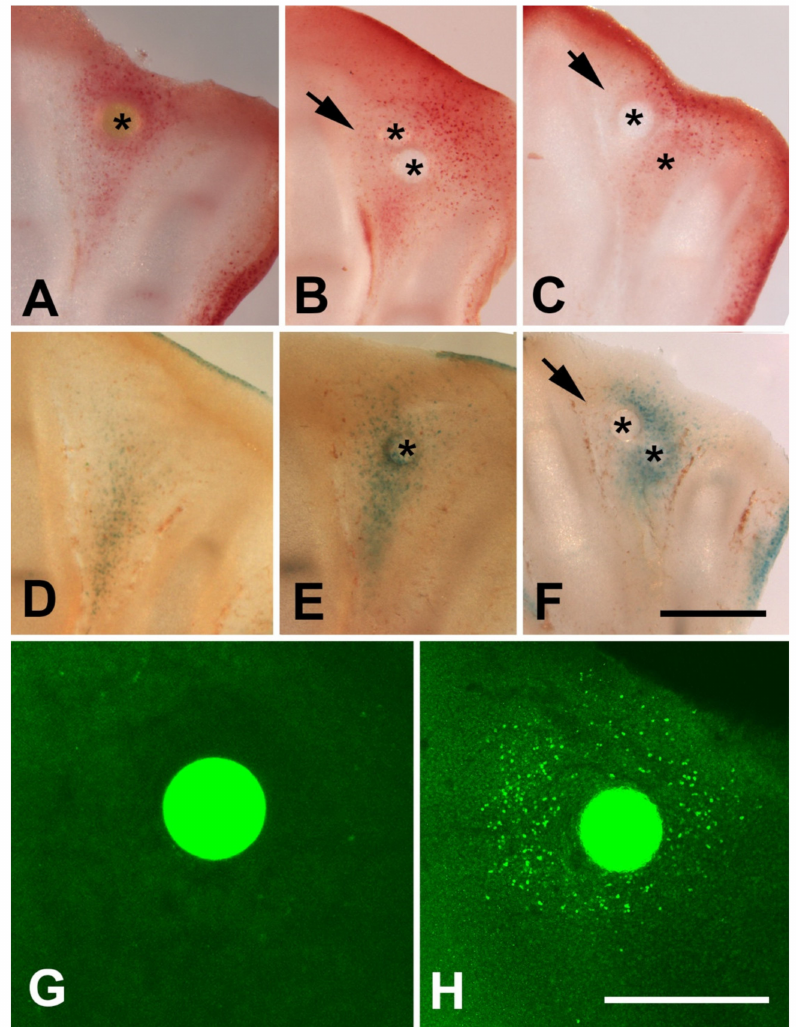
Figure 5. ( A – C ) Vibratome sections of autopods 24 h after interdigital implantation of a TSA bead alone ( A ), double implantation of Noggin and TSA bead ( B ), and double implantation of FGF bead and TSA bead ( C ). ( D – F ) Vibratome sections showing the pattern of β -galactosidase activity in control untreated ( D ) 24 h after implantation of a TSA bead, and 24 h after double implantation of a FGF bead and a TSA bead. Asterisks indicate the position of the beads. Note the inhibition of neutral red labeling and β -galactosidase activity in the zone close to Noggin and FGF bead (arrows) in comparison with single TSA treatments in ( A , E ). ( G , H ) Absence of γ H2AX-positive cells 8 h after implantation of a control PBS bead ( G ) and intense labeling after implantation of a TSA bead ( H ). Magnification bar in ( A – F ) = 400 µ m; bars in ( G , H ) = 200 µ m. Asterisks in images ( A – F ) show the position of the